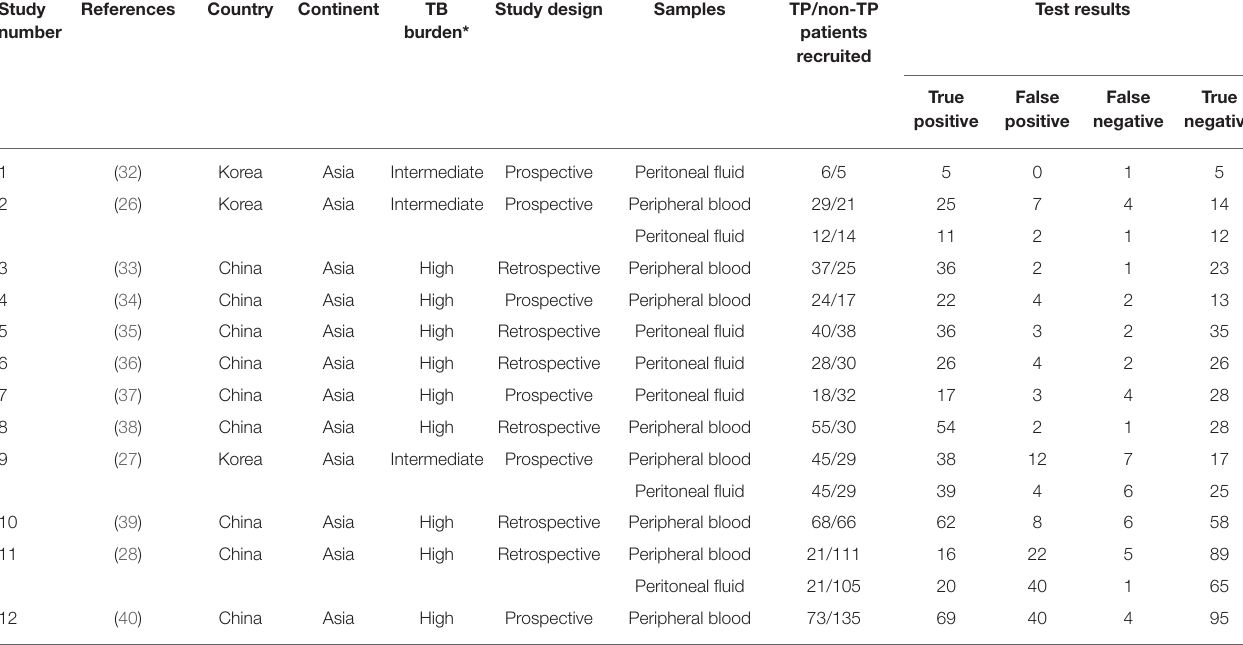
TABLE 1 | Summary characteristics of studies included in